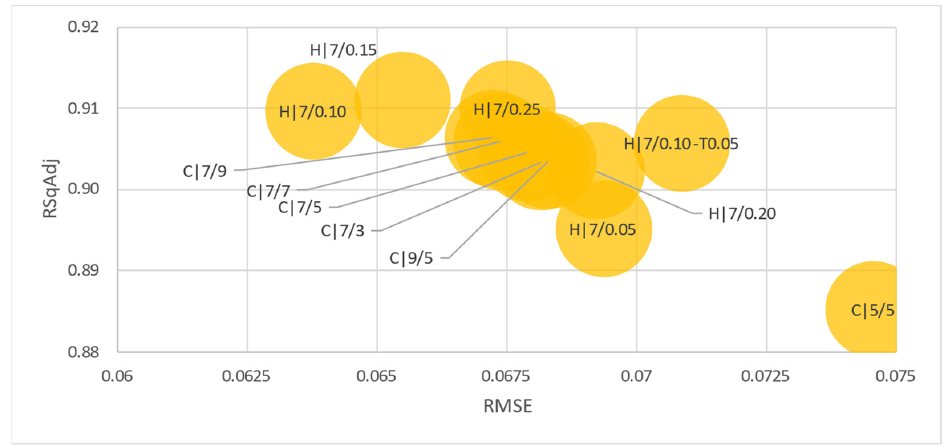
Figure 5. Exponential Gaussian process (GPR) results’ RMSE for different tested variables and validations (bubble size represents number of observations).